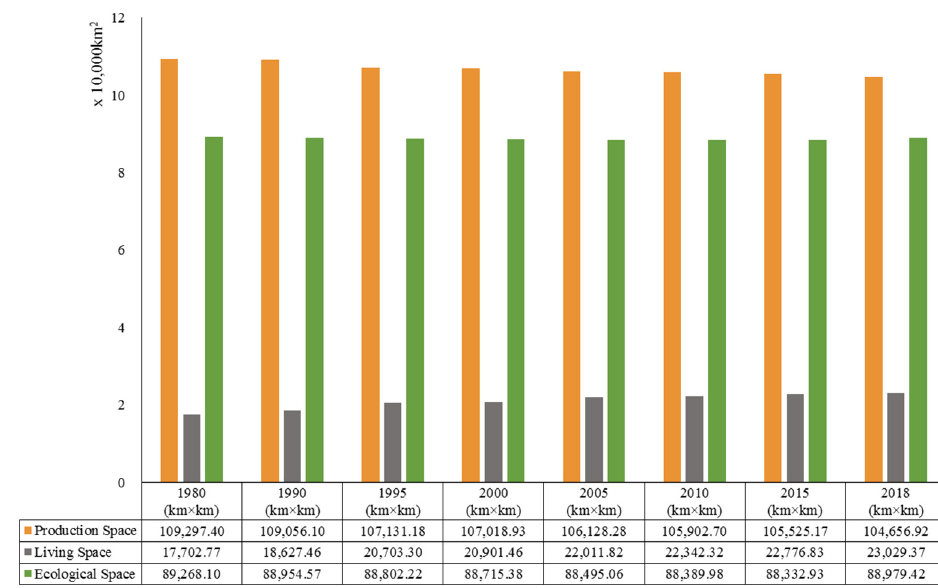
Figure 4. Area of PLES from 1980 to 2018.